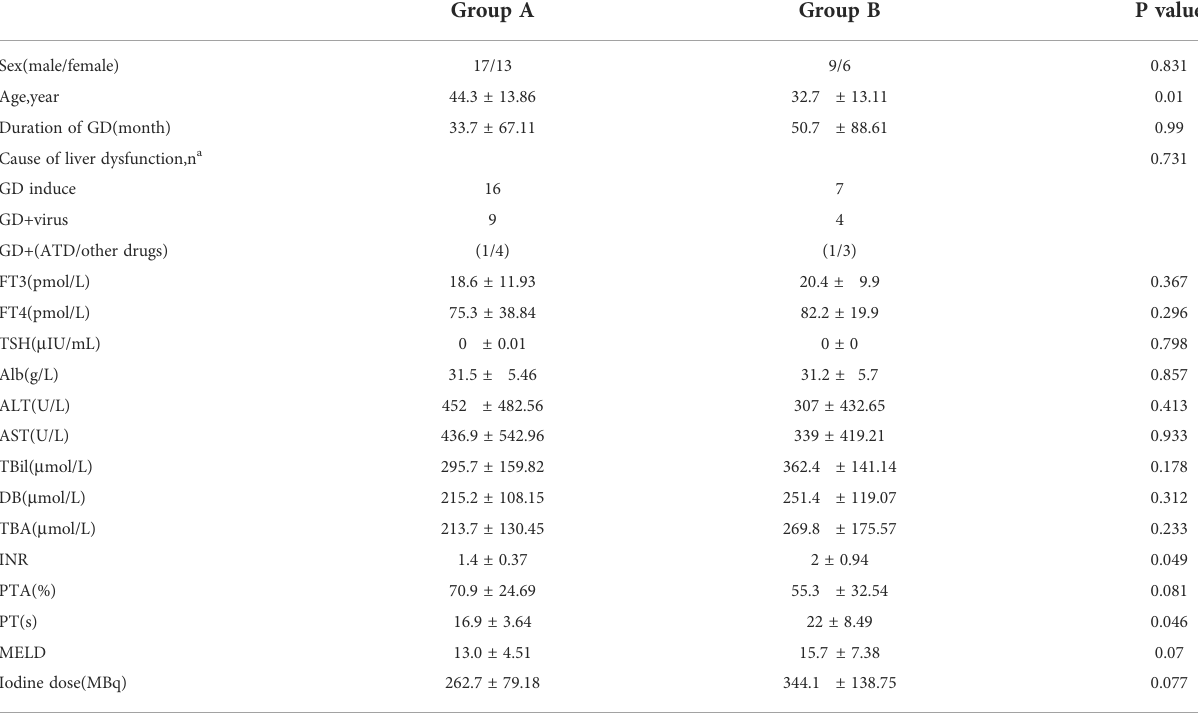
TABLE 1 Baseline characteristics of patients with Graves ’ disease and severe liver dysfunction. Group A Group B